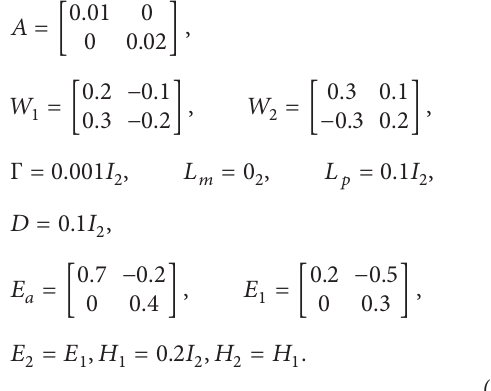
Table 3: Maximum allowable delay bounds, ℎ 𝑀 , with different ℎ 𝑚 and fixed 𝜏 = 5 (Example 11).